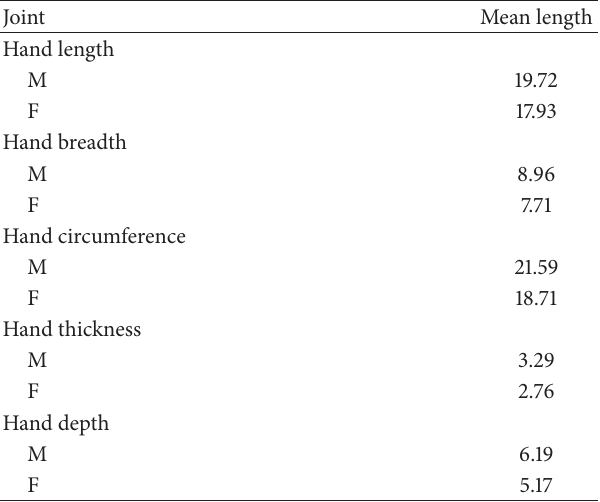
Table 2: Average hand dimensions of USAF male (M)/female (F) flying personnel [9, 10]